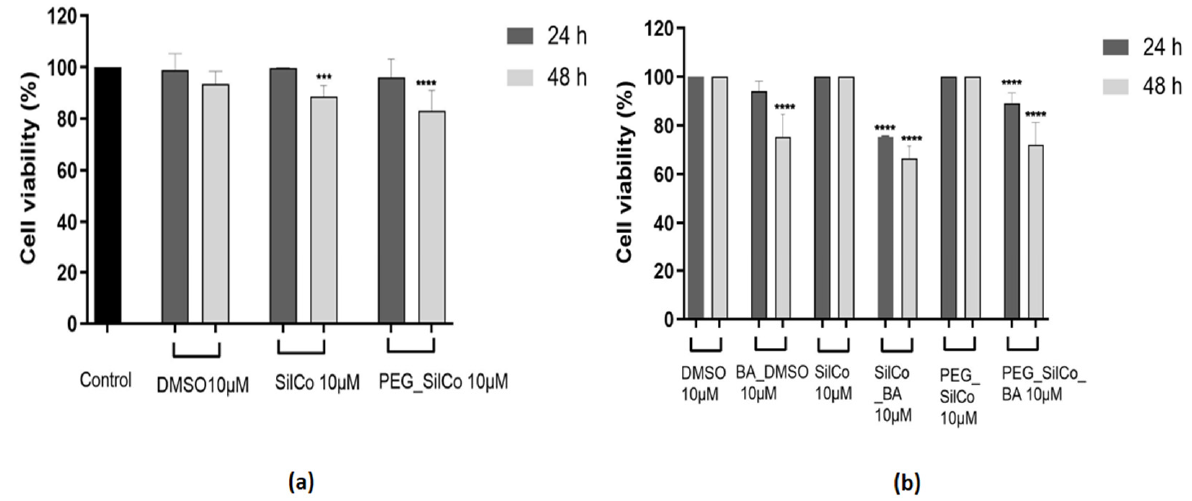
Figure 4. In vitro assessment of silver nanocolloids loaded with betulinic acid effect on human hepatocellular carcinoma (HepG2) cells viability after 24- and 48-h treatment by applying the Alamar blue assay. The data are presented as cell viability percentage (%) normalized to control cells ( a ) and to DMSO, SilCo and PEG_SilCo, respectively ( b ) and are expressed as mean values ± SD of three independent experiments performed in triplicate. To identify the statistical differences between the control and the treated group, one-way ANOVA analysis was conducted, followed by Tukey’s multiple comparisons post-test (*** p < 0.001 and **** p < 0.0001).